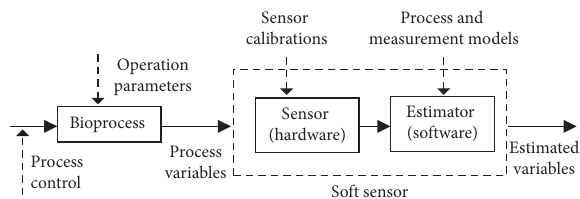
Figure 1: Principle of the soft sensor